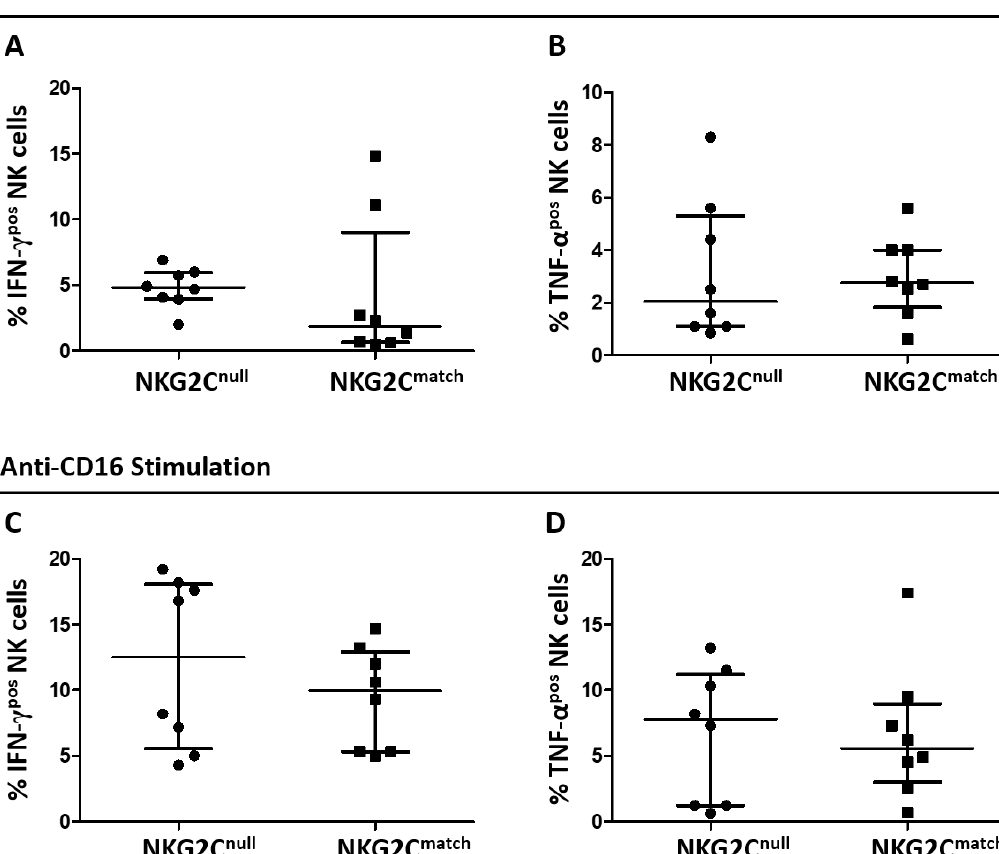
Figure 3. Comparison of cytokine responses to stimulation through NCRs or CD16 for NK cells from NKG2C null and NKG2C match groups. After overnight recovery, cryopreserved PBMC from NKG2C null and NKG2C match individuals were incubated with K562 cells ( A , B ) in 1 mL lymphocyte medium at E:T